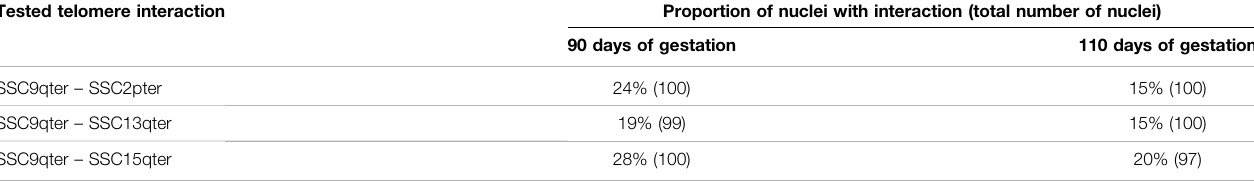
TABLE1| Numbersandproportionsofnucleiwithanobservedassociationbetweentelomeres.Proportionsofnucleiharboringtheprobedtelomericassociationsinmuscle cells at 90 and 110 days of gestation: SSC2pter – SSC9qter, SSC13qter – SSC9qter and SSC15qter – SSC9qter. For each association, ∼ 100 nuclei were analyzed. A higher percentage of association is observed at 90 days of gestation for the three tested associations. Tested telomere